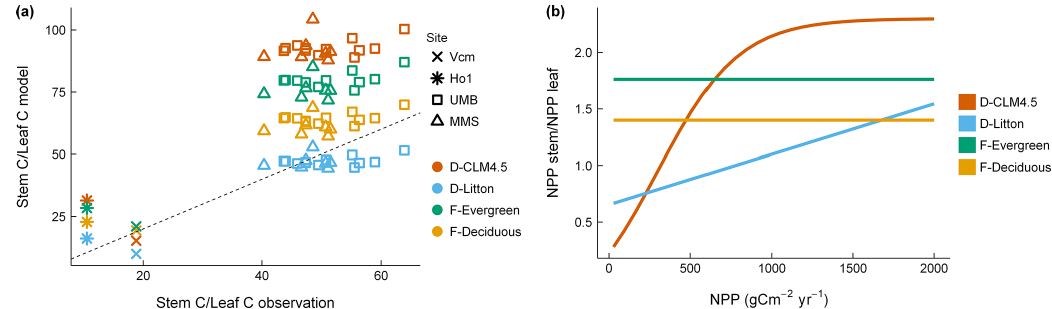
Figure 8. (a) Comparisons between C stem /C leaf ratio for the four C allocation schemes and AmeriFlux observations. (b) NPP stem / NPP leaf ratio for the different mean annual NPP values and C allocation schemes. In Fig. 8a, dashed line is 1 : 1 relationship between observations and model. Observations ( C stem and C leaf ) are from the AmeriFlux